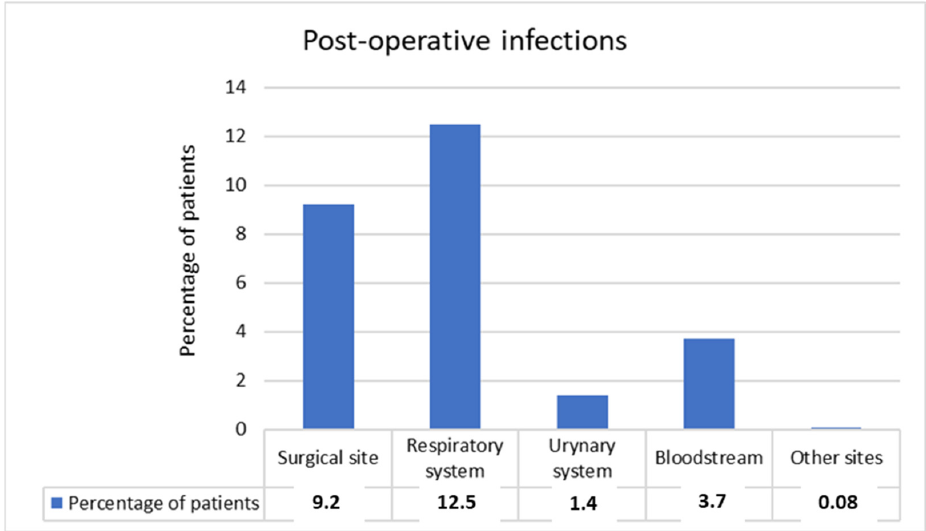
Figure 1. Sites of post-operative infections (percentages on 488 patients). Significant risk factors for post-operative infection (all the sites) at univariate anal- yses were higher ASA score, advanced stage, longer duration of surgery, tracheotomy, clean-contaminated surgical procedure, flap reconstruction, ICU stay, lower post-opera- tive Hb (first day after surgery), nasogastric feeding tube, and presence of PICC/CVC ( p < 0.05). Median Hb at the days of infection diagnosis was 10.2 g/dL (IQR 2.4 g/dL), lower than levels at first post-operative day (1.8 g/dL lower on average). Table 4 reports the percentages of infections for each site and categorical risk factor, while Table 5 shows statistical significance for risk factors according to infection sites. Older patients had a higher risk of SSIs.